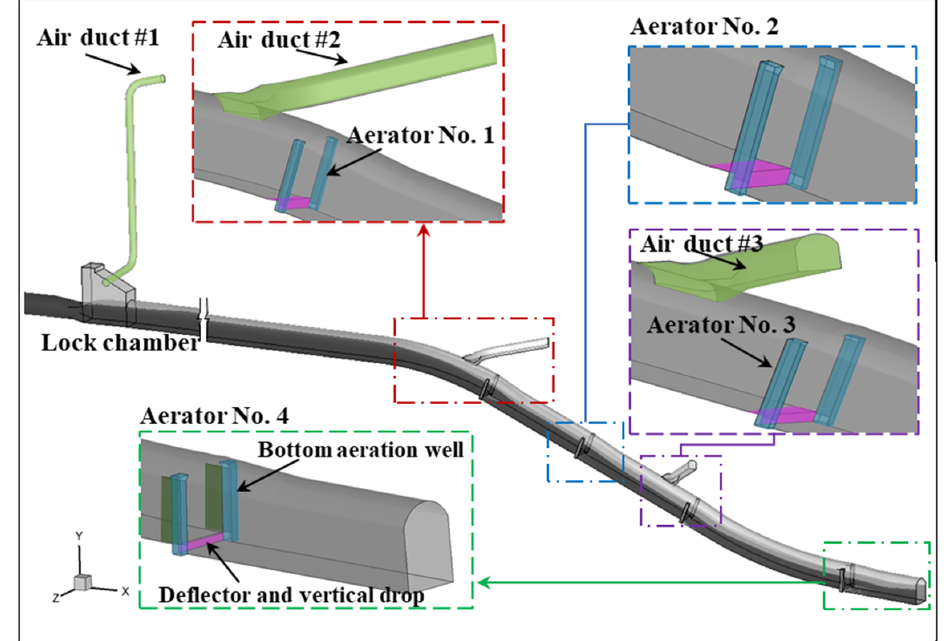
Figure 1. Layout of the spillway tunnel of Jinping-I project.